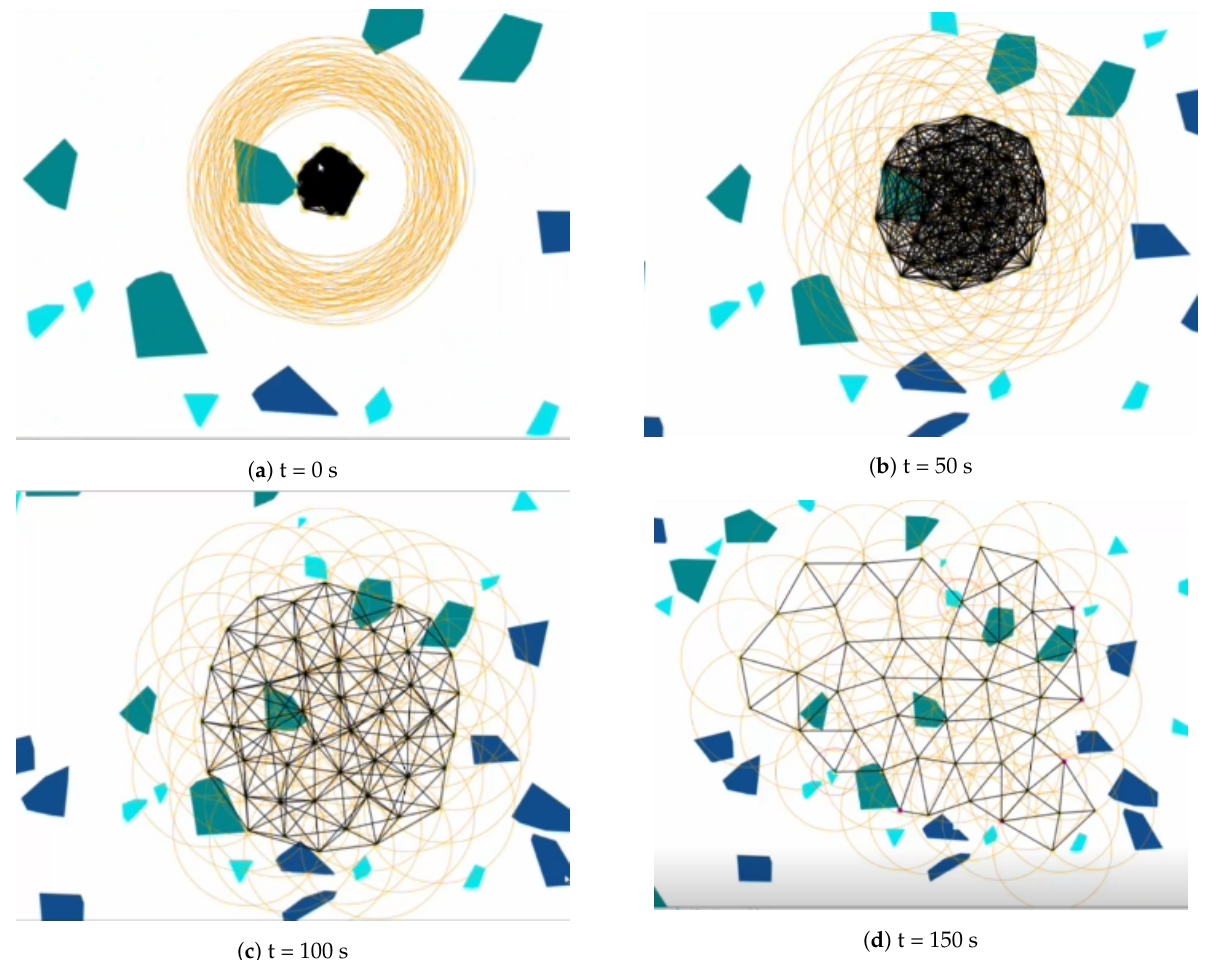
Figure 4. Dynamic Deployment process of robots. ( a ) shows the initial state, ( b ) after 30 s, ( c ) just around a minute, and ( d ) after 90 s.